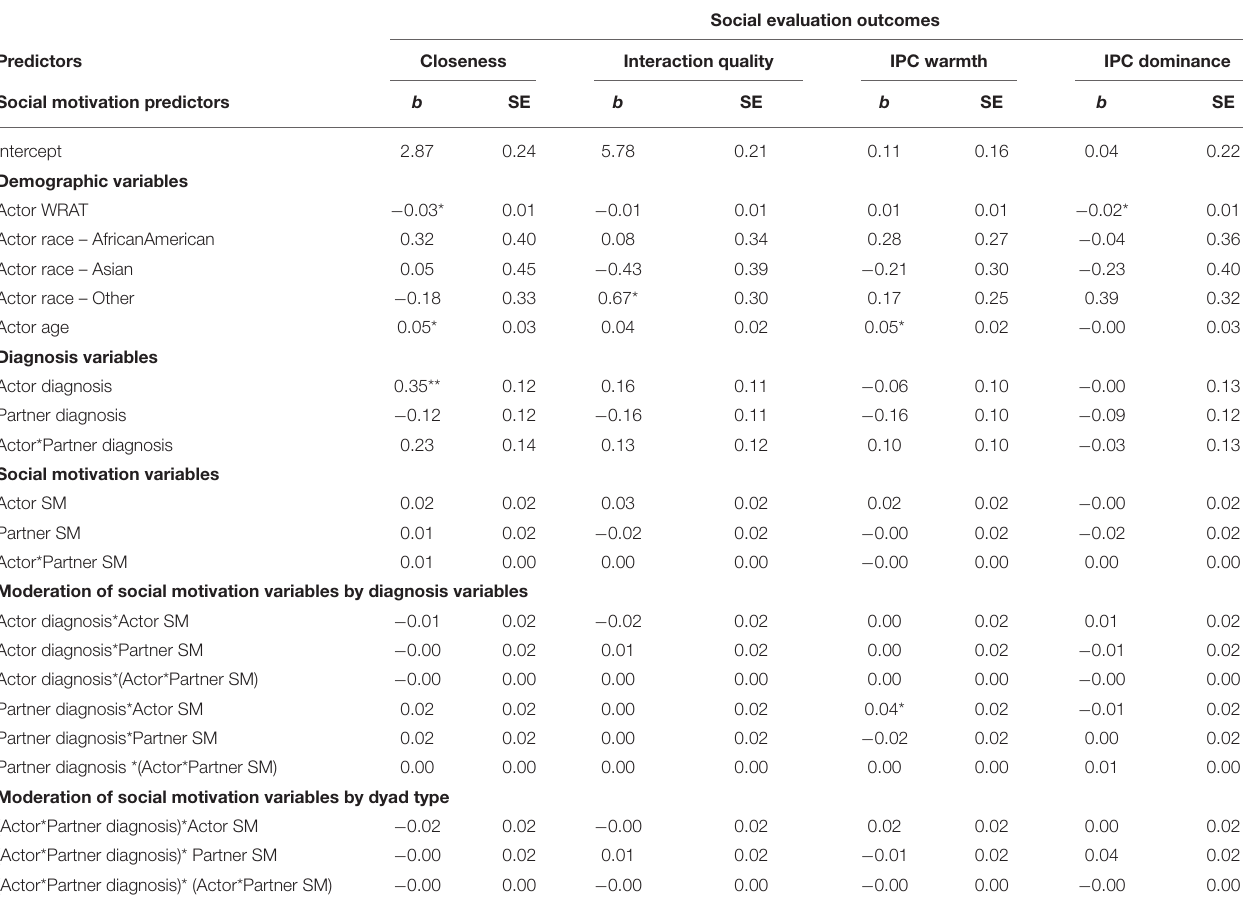
TABLE 9 | Actor-partner interdependence model analyses estimating the combinatorial effects of diagnostic status and social motivation variables on the social evaluation outcomes of closeness, interaction quality, warmth, and